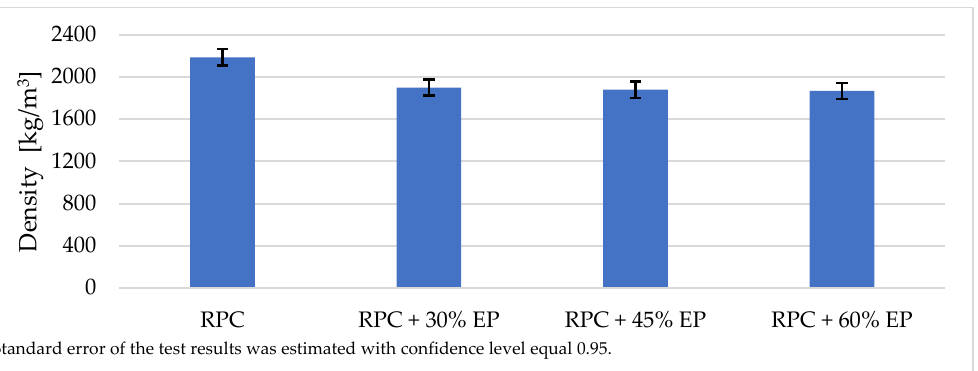
Figure 6. Density of RPC and density of RPC containing EP in quantities 30%, 45%, and 60% by volume. The reason for this phenomenon is the low crushing resistance of expanded perlite.